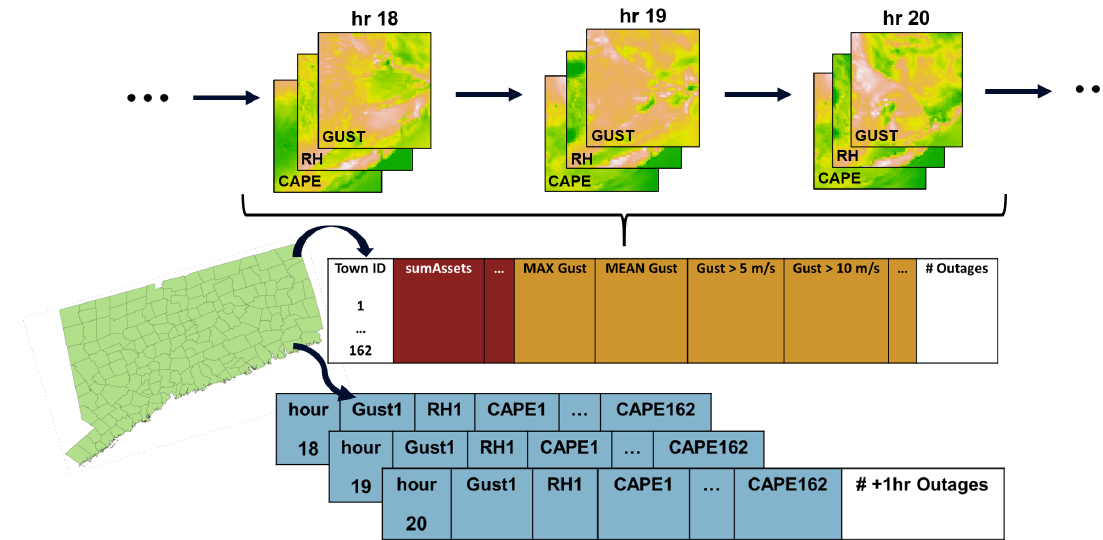
Figure 2. Illustration of 3 hrs. of CT thunderstorm weather conditions over three variables, translated into the eventwise OPM framework ( middle ) and the temporally dynamic framework ( bottom ). In the eventwise framework, the processed dataset consists, for each storm, of static geospatial features and statistical aggregations of weather features over the course of the storm. This data is indexed by town ID. In the temporally dynamic framework, the dataset consists of direct timeseries samples of the weather features. The index is time, and town IDs are associated with each weather feature. A toy data sample in the temporally dynamic framework is illustrated with a 2-hr. lookback, predicting outages one hour